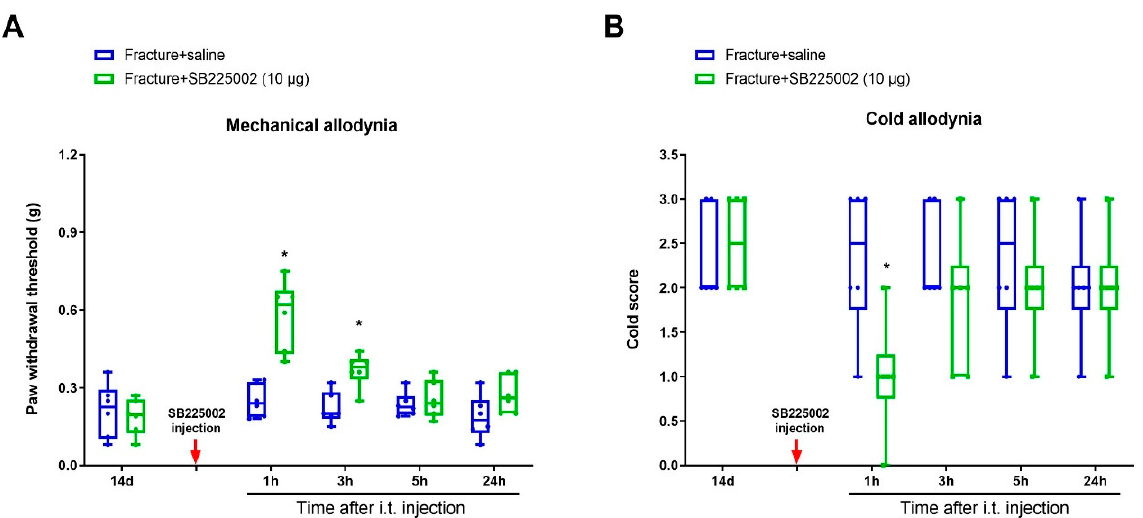
Figure 4. Spinal CXCR2 antagonism reduces the established fracture-caused chronic allodynia. The selective CXCR2 antagonist SB225002 (10 µ g) was intrathecally (i.p.) injected on day 14 after orthopedic surgeries. ( A , B ) Single injection of SB225002 reduces the established mechanical allodynia and cold allodynia. Results are expressed as medians with interquartile ranges and individual data plots ( n = 6). All behavioral data are analyzed by two-way ANOVA with Bonferroni post hoc comparisons. * p < 0.05 vs. group Fracture + saline.